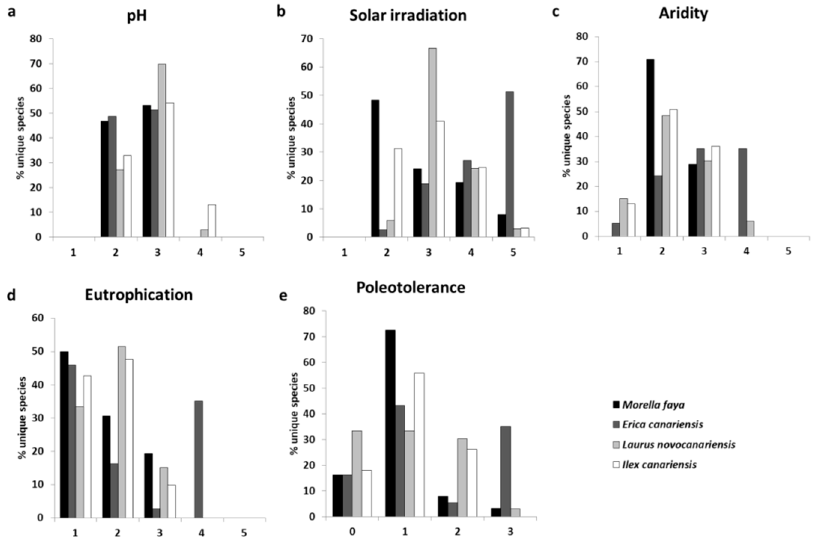
Figure 5. Percentage of unique species in each category of functional groups value and phorophytes studied: ( a ) substrata pH, ( b ) solar irradiation, ( c ) aridity, ( d ) eutrophication, and ( e ) poleotolerance. Table 4. ANOSIM and SIMPER. ANOSIM values above the diagonal (significant differences shown with *) and SIMPER values on the diagonal and under it (*: p -value ≤ 8.3 × 10 − 3 ). Morella Erica Laurus Ilex Morella 8.9 0.084 0.35 *